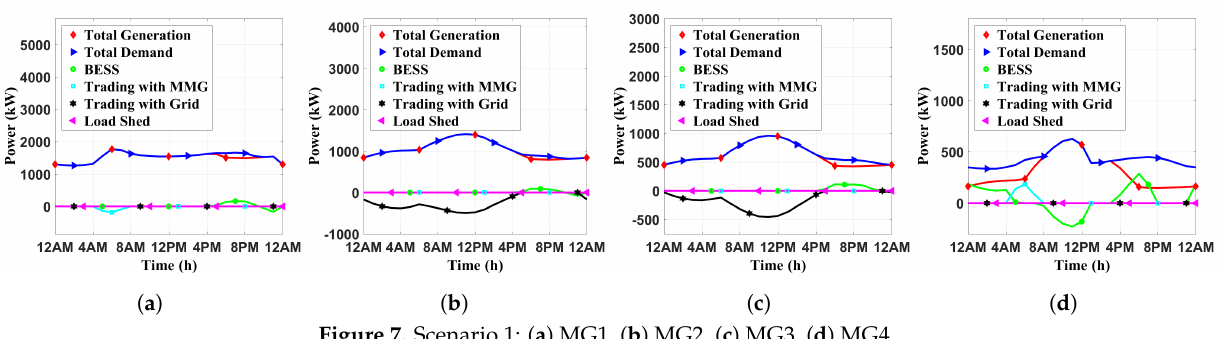
Figure 7. Scenario 1: ( a ) MG1, ( b ) MG2, ( c ) MG3, ( d ) MG4.